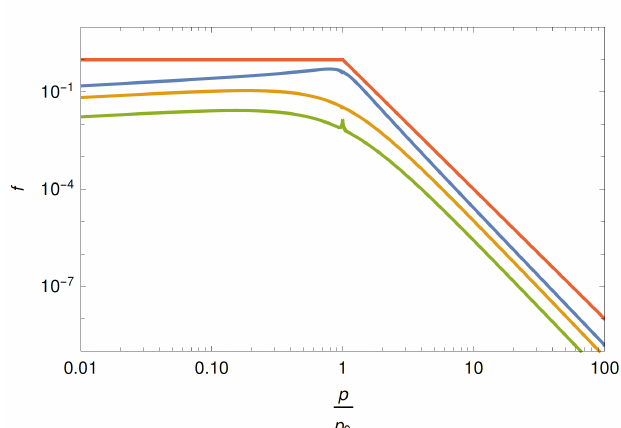
Figure 8. Normalized steady-state particle distribution function f ( r , p (cid:48) ) in the presence of a gradual, ) , shown for three different hyperbolic relativistic shear flow as a function of momentum ( p (cid:48) / p (cid:48) 0 spatial locations, r = 0.06 (blue), r = 0.50 (orange), r = 1.20 (green). Mono-energetic particle injection with p (cid:48) at r 1 = 0.02 and an outer (escape) boundary at r 2 = 2 have been assumed. A linear 0 momentum-dependence α = 1 has been used for the scattering time. The red curve (top) shows the expected power-law dependence f ( p (cid:48) ) ∝ p (cid:48)− 4 above p (cid:48) , as inferred from the Fokker-Planck approach 0 in Equation